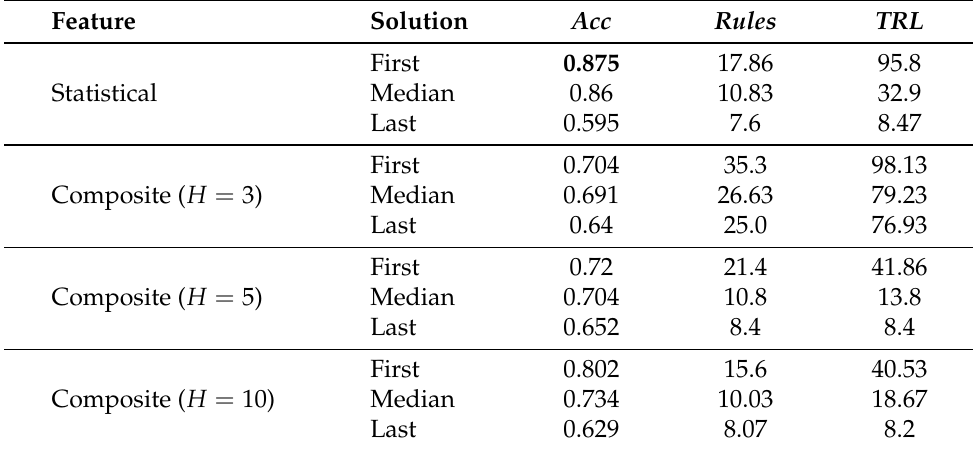
Table 13. Performance achieved by the proposed classifier over the UniBS data set.